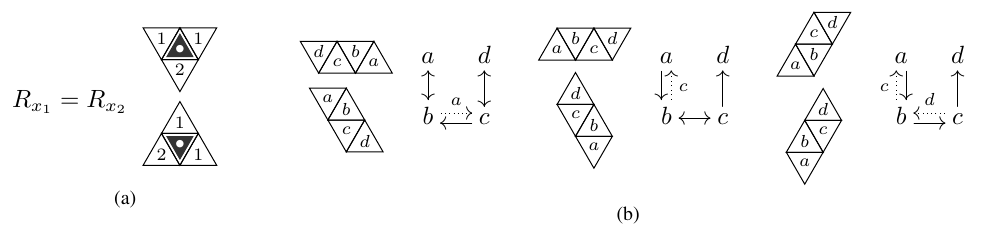
Figure 8: (a) A (2 , 4) priority strategy for the breaker for T 4 , 1 . (b) Dependency digraphs of the cells in the orientations of T 4 , 1 .